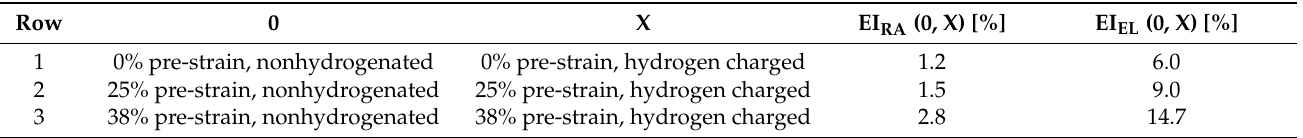
Table 2. Hydrogen embrittlement indices of variously pre-strained 316H steel